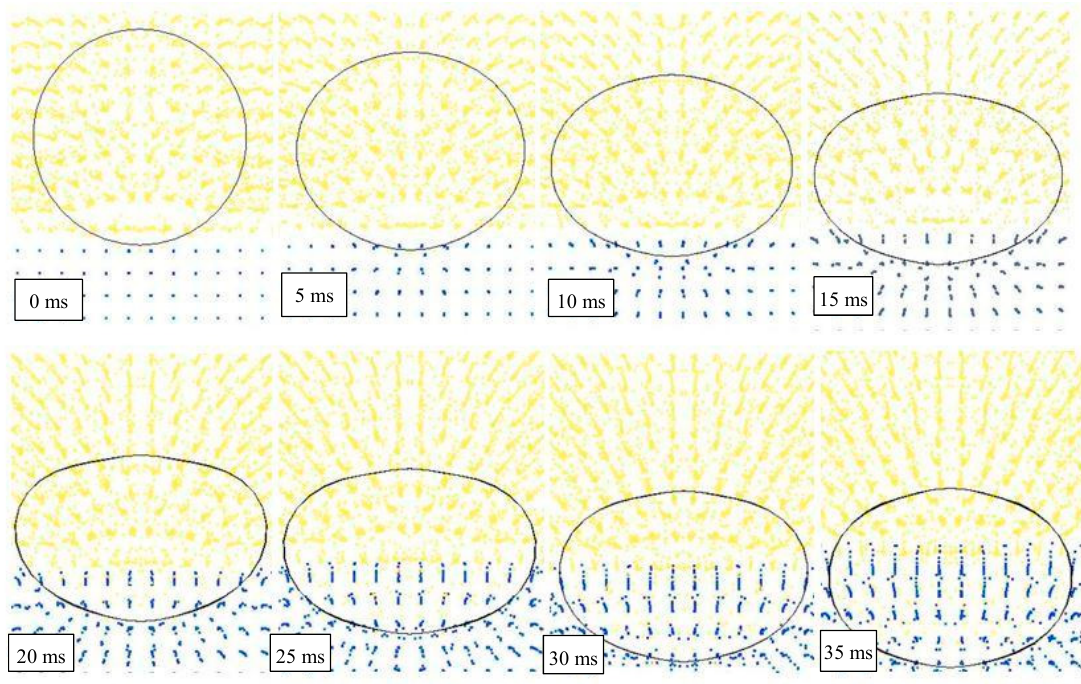
Figure 9. Impact numerical results considering the air effect (drop height of 1500 mm).